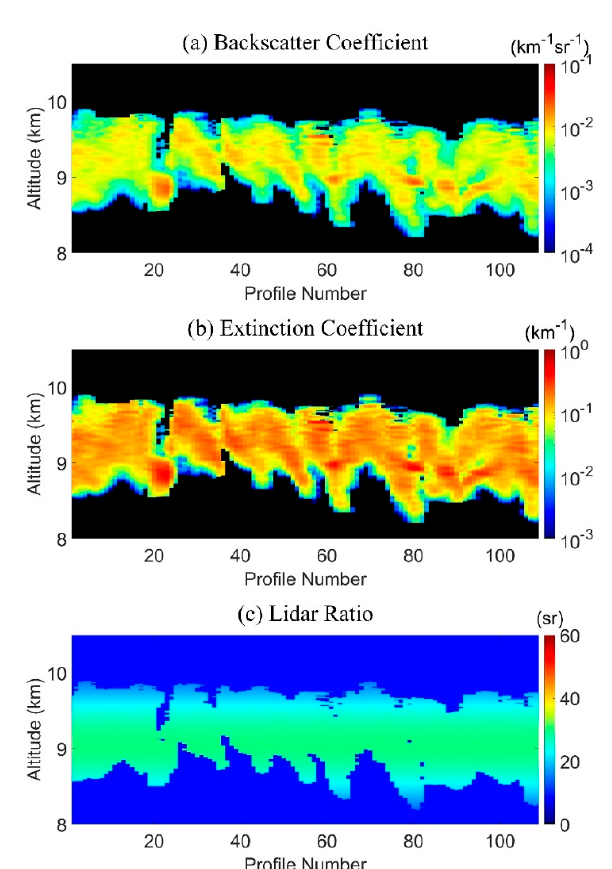
Figure 3. ( a ) The backscatter coefficient, ( b ) the extinction coefficient, and ( c ) the lidar ratio used in the simulation experiment. The lidar ratio inside the clouds is modeled in Gaussian with a value of 26.28 ± 3.63 sr, while it is 8 /3 π for the background region.